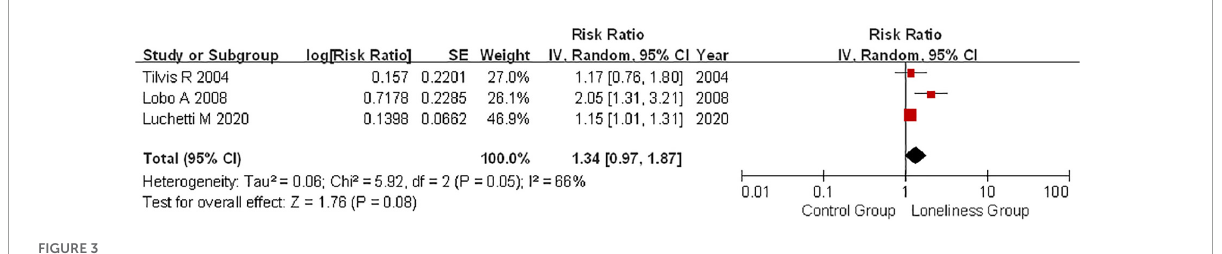
FIGURE3 Random effects analysis of fully adjusted studies for the association between loneliness and mild cognitive impairment (MCI) risk. The square box in the graph portrays the weight that each study contributed to the analysis. CI, confidence interval; IV, inverse variance; SE, standard error; MCI, mild cognitive impairment.